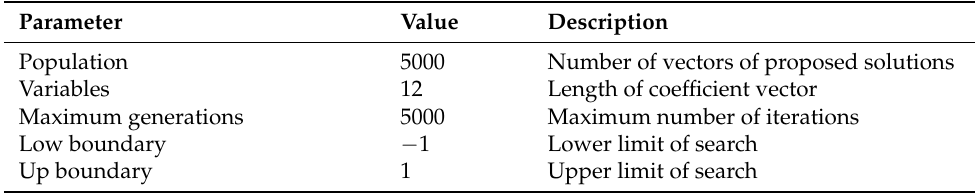
Table 3. General parameters used by the Jaya